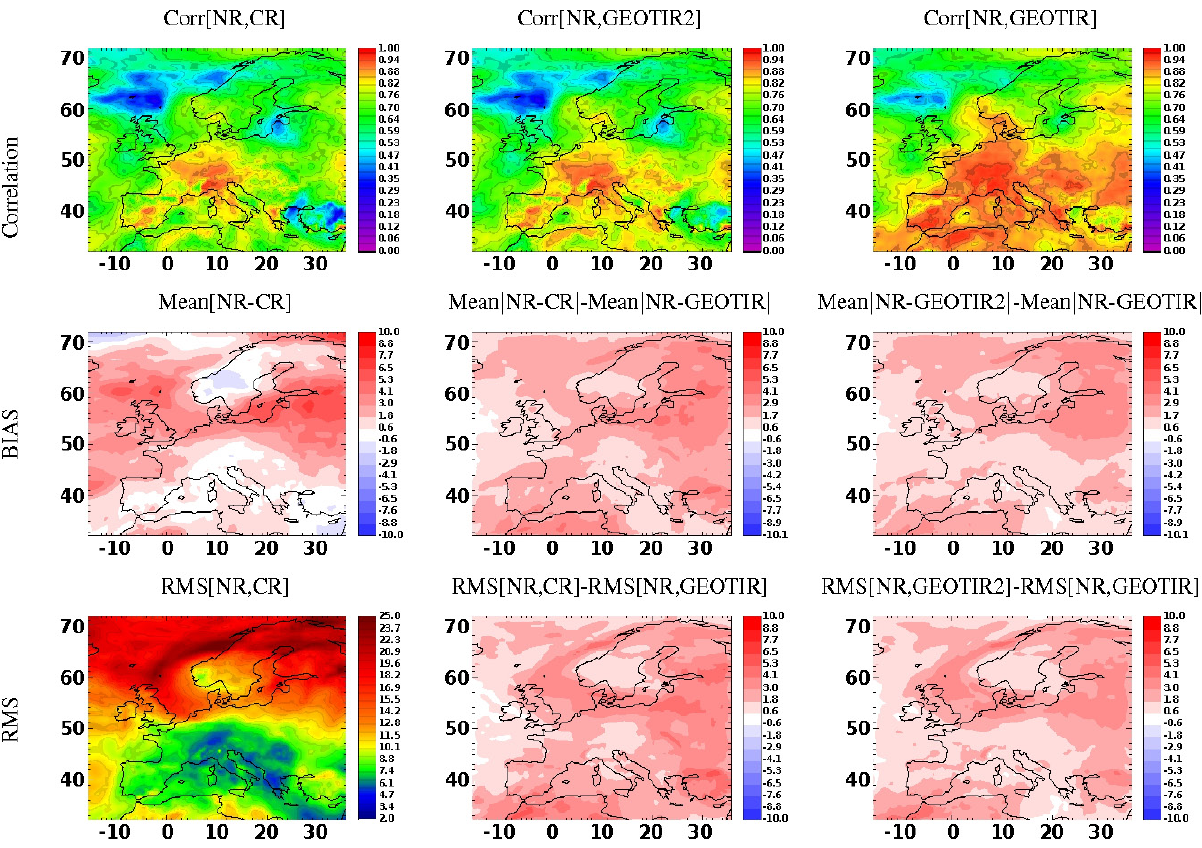
Fig. 9. Same as Fig. 5 but for the experiment with a change in the initial condition